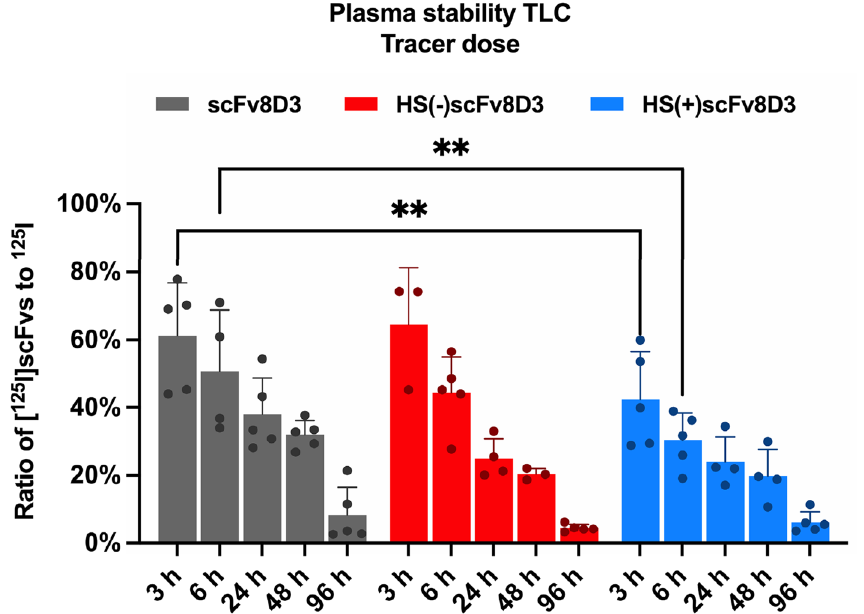
Figure 5. In vivo plasma stability of [ 125 I]scFvs constructs. TLC analysis was performed on plasma samples from mice at the indicated times, following an intravenous injection of the 125 I radiolabeled scFv constructs (0.3 nmol/kg). Semi-quantitative estimation of the ratio between the [ 125 I]scFvs to free 125 I was performed by measuring optical density with Fiji (ImageJ) software 44 . Results are presented as mean ± SD and statistical comparisons were conducted between HS(−)scFv8D3 and HS(+)scFv8D3 to scFv8D3. * Represents a significance of P < 0.05, ** Represents a significance level of P < 0.01.